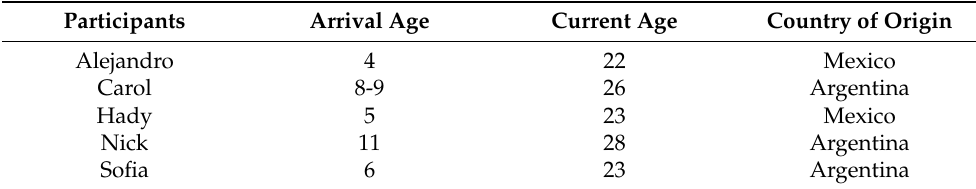
Table 1. Participant